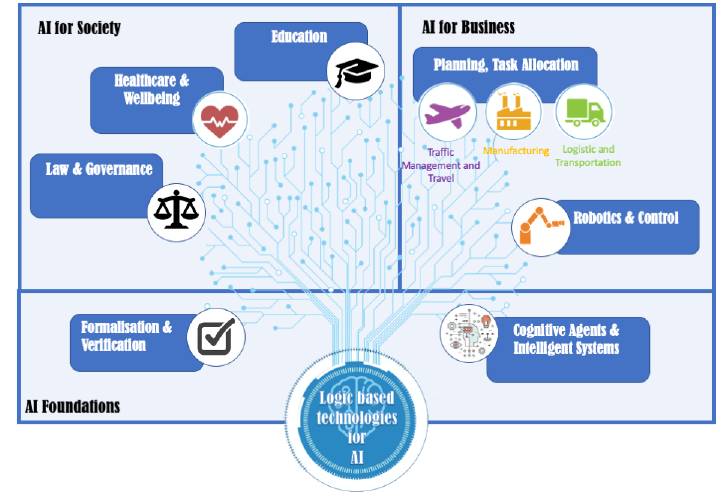
Figure 2. Logic-based technologies application areas with respect to the main AI categories—namely AI Foundations, AI for Society, and AI for Business. Intentionally, the picture only illustrates the AI areas that are closely related to logic.